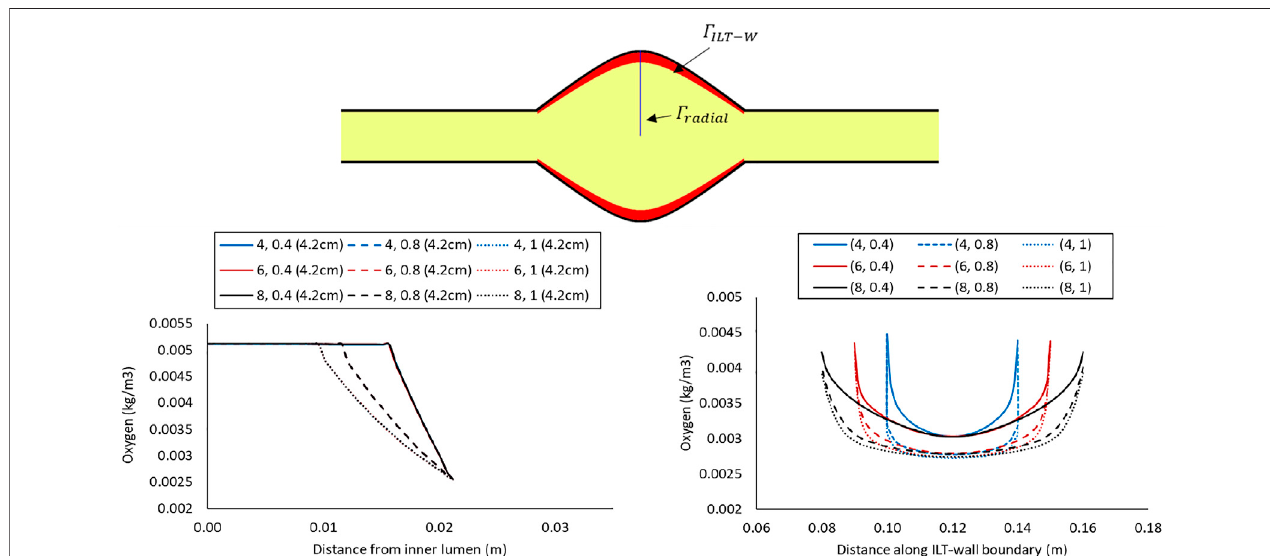
FIGURE4 | Comparison ofthe oxygen concentrationalong aradial path lineat halfwayalong thelength ofthe lumen in thecases with BD =4.2 cmand varying ILT length( l )and ILTthickness( δ ) denoted bycase ( l , δ ) (left),and comparison oftheoxygenconcentrationalongtheaxial lengthon theinteriorinterfaceofthearterialwall in the same cases (right). In both plots, the blue, red, and black lines represent the short, medium, and long ILT cases information respectively; and solid, dashed, and dotted lines represent thin, moderate and thick ILT cases respectively. All nine cases are shown in Figure 2 . At the top, these path lines are shown with blue line, Γ Γ Γ radial for the left plot and ILT − W for the right plot. The ILT − W represents the interface between the ILT (red region) and wall domain (black region).